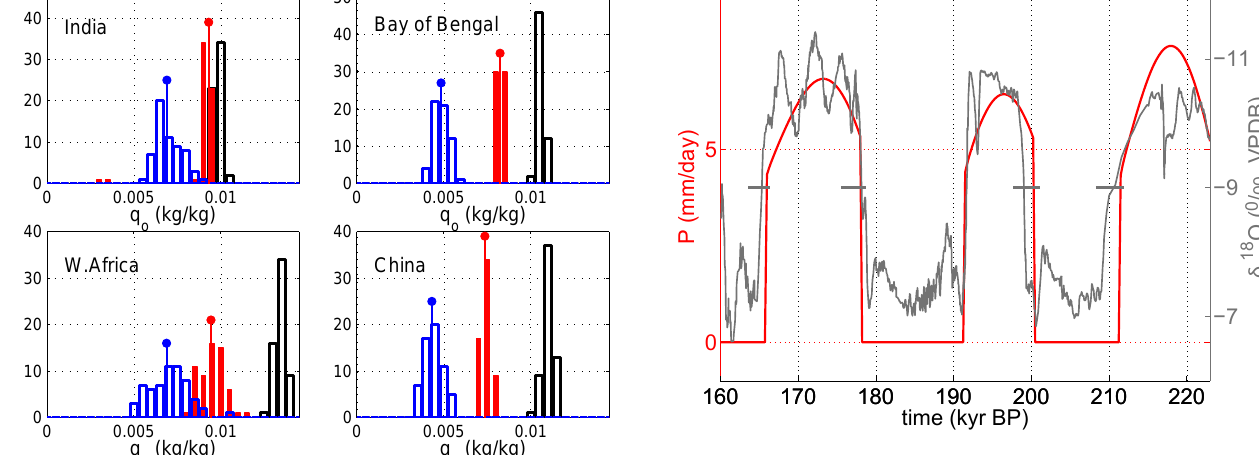
Fig. 9. Estimate of critical specific humidity value over the ocean, q c o , from NCEP/NCAR reanalysis data for the basic minimal model (blue) and including the effect of a minimum terrestrial humidity q o required for the onset of precipitation (red). The black histogram shows the observed distribution of q o . Pins mark the estimates ob- tained from time-mean parameter values.